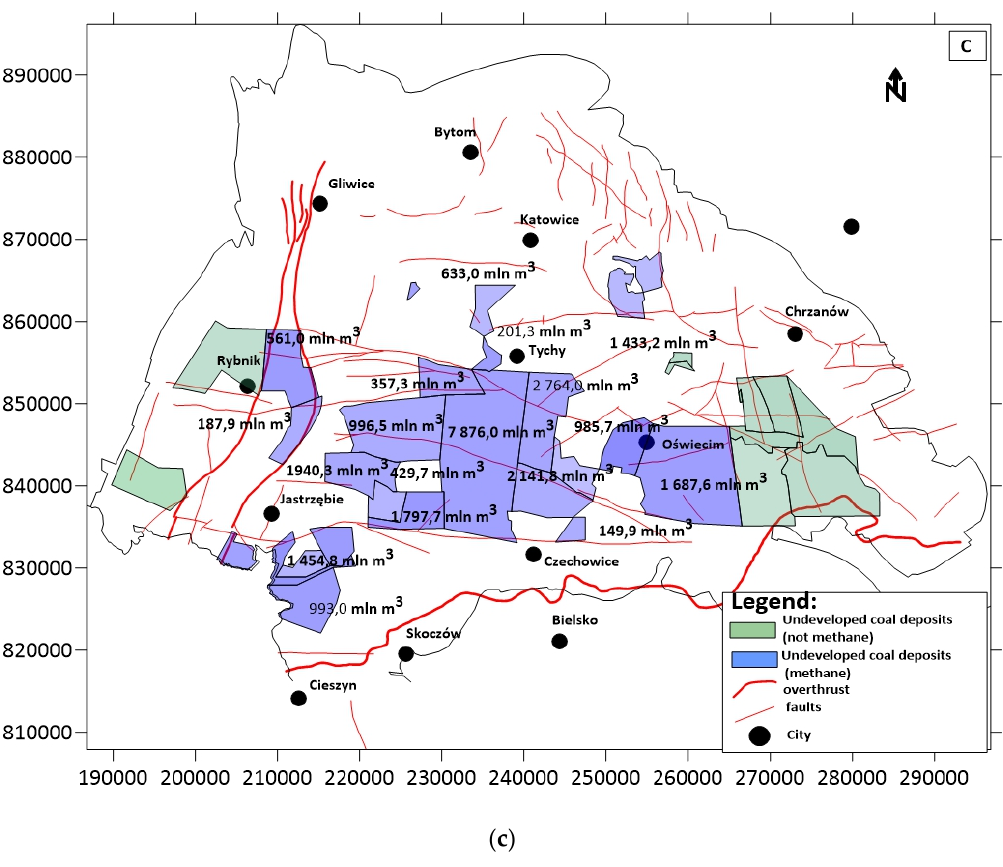
Figure 1. Maps of coal bed methane (CBM) resources occurring in undeveloped areas of the Upper Silesian Coal Basin, Poland for three depths: ( a ) up to 1000 m, ( b ) 1000–1250 m, and ( c ) 1250–1500 m.